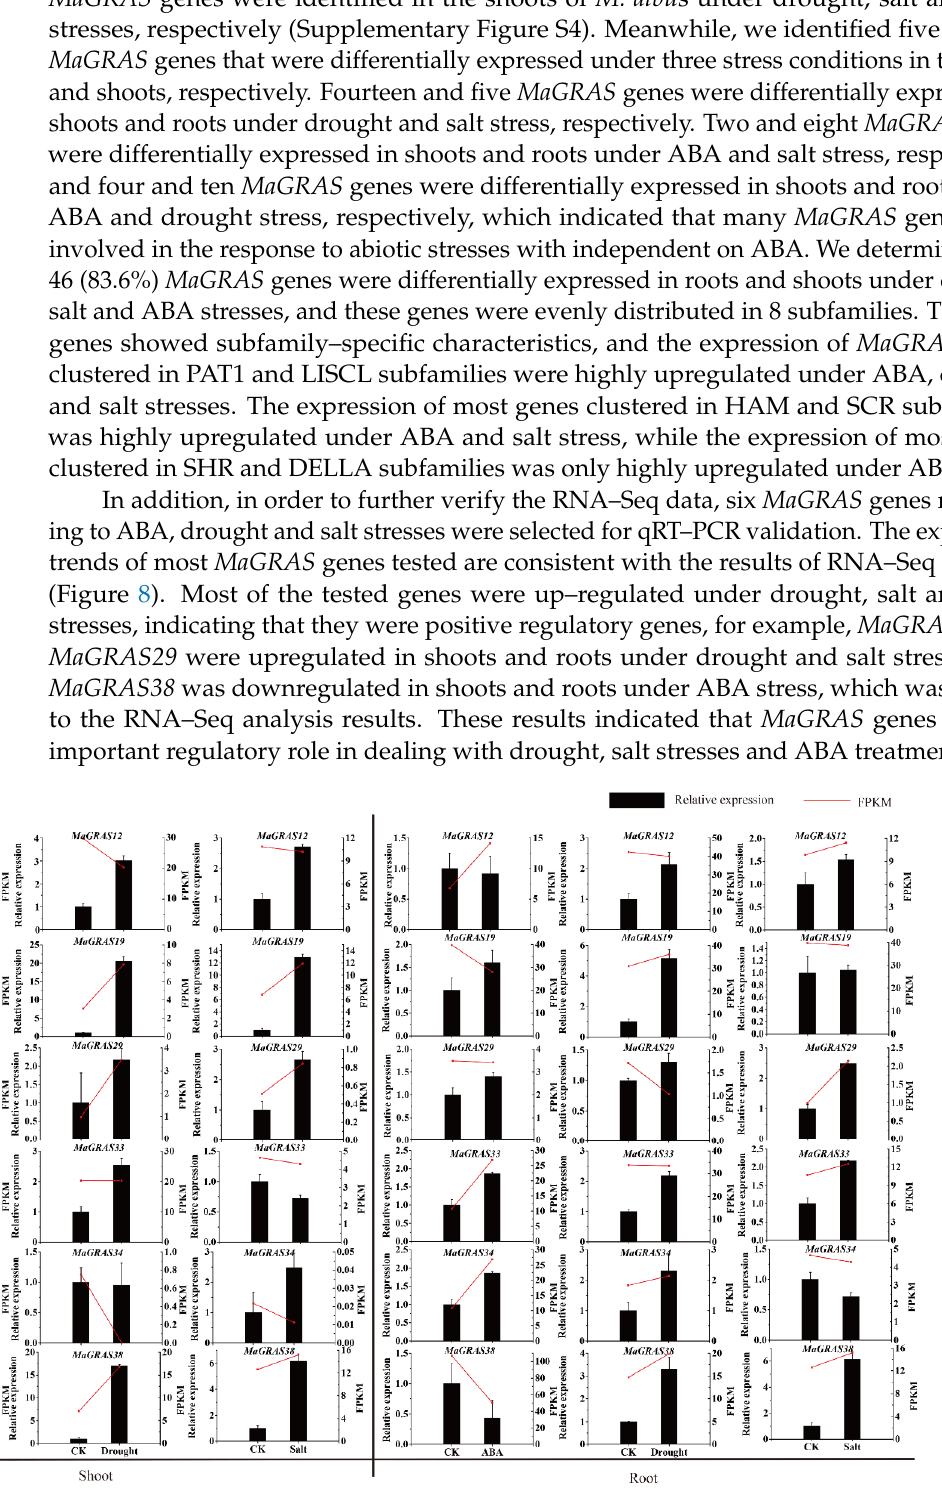
Figure 8. Gene expression analysis of six MaGRAS genes in shoots and roots under drought, salt and ABA treatments using qRT − PCR . CK represents control. Red lines indicated the expression ABA treatments using qRT–PCR. CK represents control. Red lines indicated the expression values values (FPKM) from RNA − seq data and the displayed values show the means ± standard deviation (FPKM) from RNA–seq data and the displayed values show the means ± standard deviation of of three replicates. three